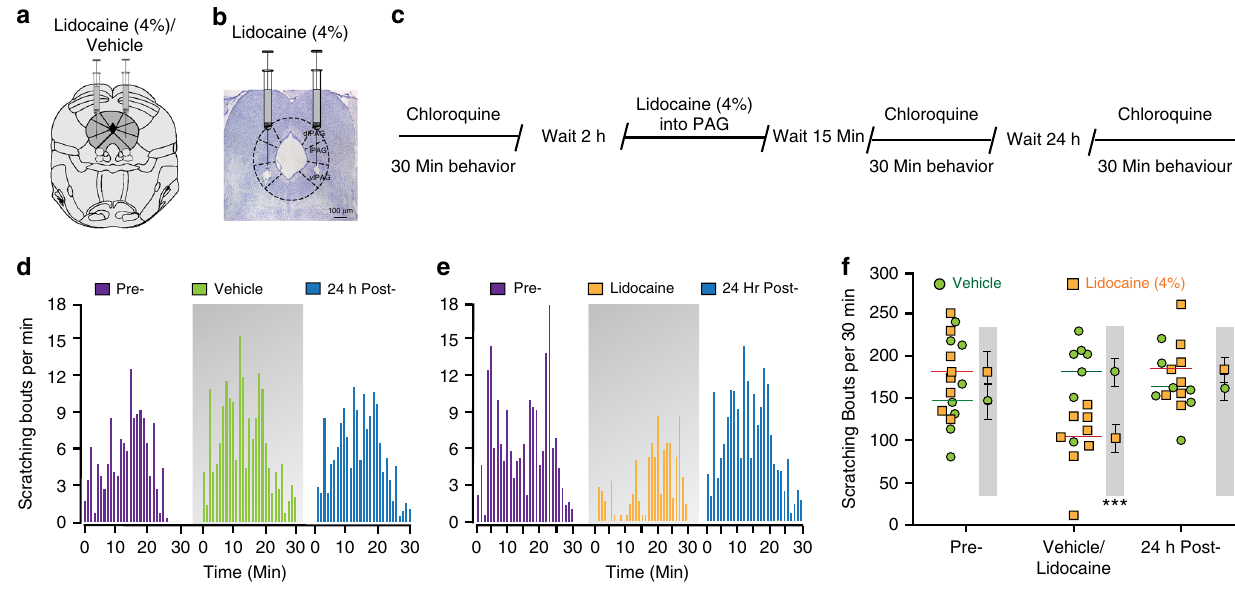
Fig. 1 Pharmacological inactivation of the vlPAG attenutates scratching behavior. a Representation of bilateral placement of guide cannulae in the vlPAG in mice injected with vehicle/lidocaine. b Representative histological veri fi cation showing bilateral microinjection of lidocaine into the vlPAG. c Experimental timeline for examination of behavioral effects of bilateral microinjection of lidocaine into the vlPAG on chloroquine evoked scratching. d , e Histograms demonstrating the mean number of scratching bouts per minute for a 30-min period. d Microinjection of vehicle (0.9% saline) into vlPAG did not produce any effects on chloroquine evoked scratching when compared to baseline and 24-hour post-vehicle treatment. e Microinjection of lidocaine into vlPAG resulted in signi fi cant suppression of chloroquine evoked scratching when compared to baseline and 24-hour post-lidocaine treatment. f Summary quanti fi cation of vehicle and lidocaine microinjection effects on chloroquine evoked scratching. Data represents the total number of chloroquine evoked scratching bouts per individual mouse at prior to treatment, following injection of vehicle/lidocaine, or 24 h post-treatment with lidocaine (orange squares) or vehicle (green circles) treatment ( N = 8 per group, two-way ANOVA, P < 0.0001 after lidocaine microinjection; Interaction; F (2, 14) = 26.46, *** P < 0.0001. Pre vs. Post Lidocaine; F (2, 14) = 14.26, ^^^ P < 0.0001. Vehicle vs. Lidocaine; ### F (2, 24) = 4.71, P = 0.0001). Values in the gray shaded areas represent the mean ± SEM of all animals, for which individual values are shown in the un-shaded areas (horizontal lines represent means). Source data